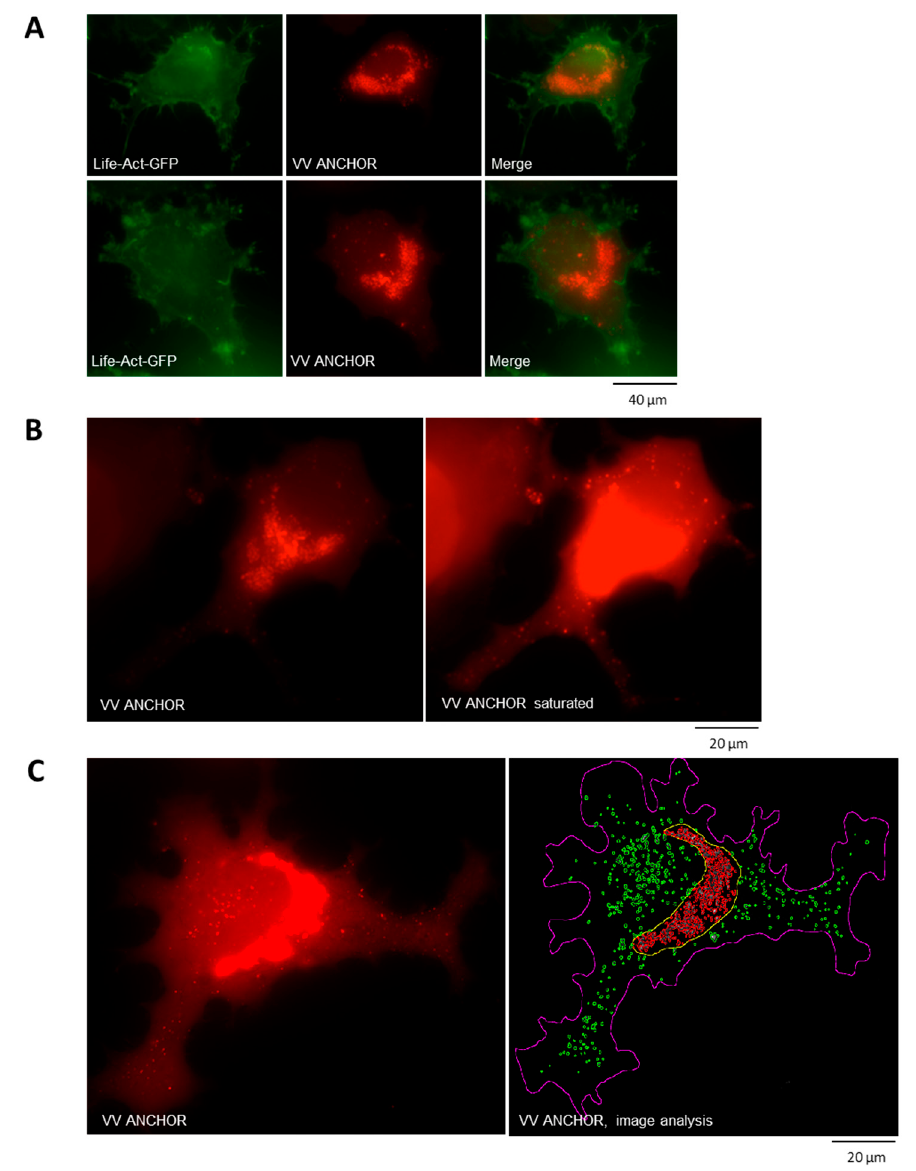
Figure 2. Visualization and quantification of VACV ANCHOR dynamics and copy number in living cells. ( A ) HeLa cells were transfected with plasmid LifeAct-GFP using Extreme Gene HP (Roche). One day post-transfection, cells were infected with VACV ANCHOR at MOI 0.25. Twenty-one hours post-infection, cells were imaged on a Zeiss Axiovert Z1 microscope (GFP lamp 40%, 200 ms exp., Santaka lamp 14%, 100 ms expo). A maximum projection of A 20 frame Z-stack every 1 µ m is displayed after out of focus frame removal. Actin is stained in green and VACV DNAs are indicated in red. ( B ) Detection of cytoplasmic particles was done by saturating the fluorescence signal using Fiji (right) from the original image (left) of infected HeLa cells as in A. Images were acquired on a Zeiss Axiovert Z1 63 × oil, lamp 40% expo 120 ms, Z stack 20 frames 1 µ m interval, Z projection max intensity. VACV DNAs are indicated in red. ( C ) Intracellular quantification of VACV ANCHOR accumulation in living cells was done using Matlab and Image J. Left, VACV DNAs are indicated in red. Right, cell outline is indicated by a purple line, replication center outline is indicated by a yellow line, cytoplasmic VACV DNAs are indicated in green and VACV DNAs in the replication center are indicated in red. For copy number calculation, the smallest detectable fluorescence particles were assigned to a single copy level. According to the integrated intensity of clusters, VACV DNA copy number can be determined reaching 1090 copies in the RC and 592 copies in the cytoplasm.